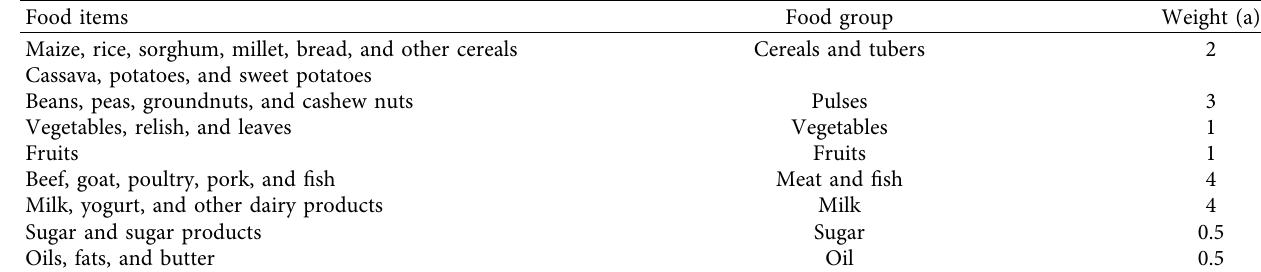
Table 2: Group of food used for FCS.